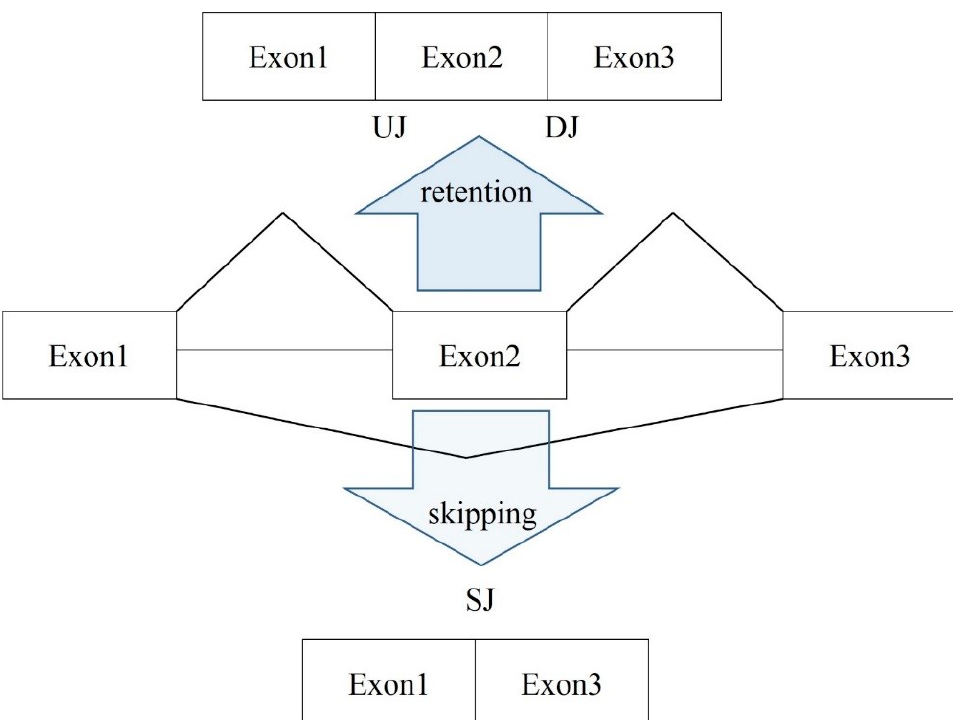
Figure 2. Scheme of exon skipping identification. Three consecutive exons are employed. The reads overlapping exon junctions are selected. UJ is upstream (exon) junction; DJ, downstream (exon) junction; and SJ, skipping (exon) junction. The coverage rate of the corresponding junctions allow for the inference of the major isoform. Lack of SJ reads implies that no ES event is observed at the site.